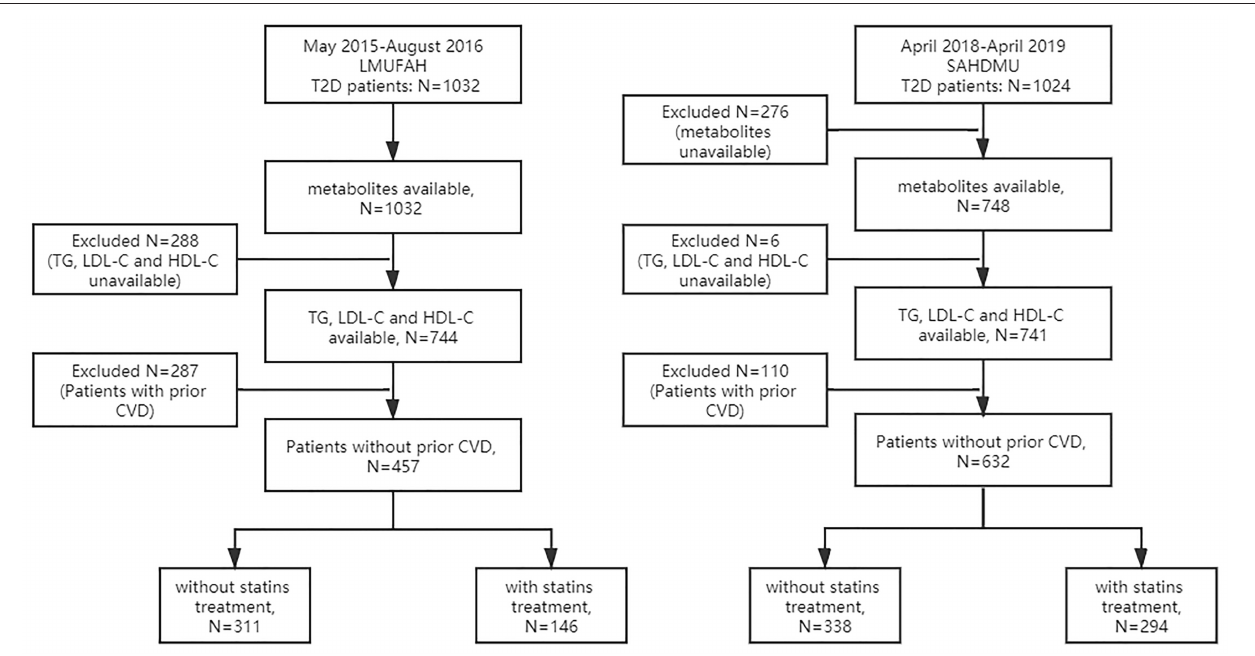
FIGURE 1 | Flow diagram of selection of subjects included in this study. LMUFAH, Liaoning Medical University First Affiliated Hospital; SAHODMU, the Second affiliated hospital of Dalian Medical University; T2D, type 2 diabetes; TG, triglyceride; LDL-C, low-density lipoprotein cholesterol; HDL-C, high-density lipoprotein cholesterol; CVD, cardiovascular diseases, including coronary heart disease and stroke.